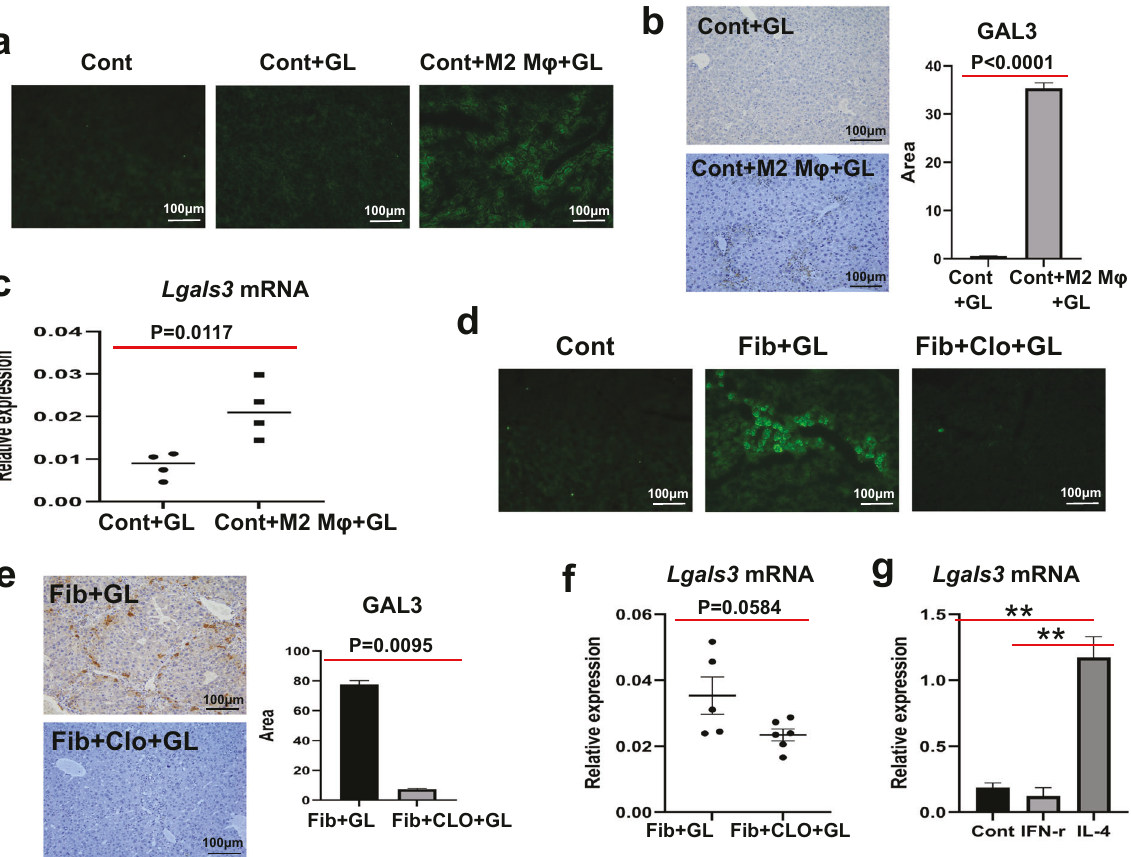
Fig. 4 M2-like macrophages act as a key regulator of GAL3 expression. a , b GAL3 expression in acutely injured mice with or without M2-like macrophage transfer. c The mRNA levels of Lgals3 in the livers of acutely injured mice with or without M2-like macrophage transfer. d , e GAL3 expression in fi brotic mice upon insult with or without M2-like macrophage depletion. f The mRNA levels of Lgals3 in the livers of fi brotic mice upon insult with or without M2-like macrophage depletion. g The mRNA levels of Lgals3 in M0, M1 or M2 macrophages ( a – c : n = 4; d – f : n = 4 – 6; g : n = 3). Group comparisons were performed using Student ’ s t test, the Mann – Whitney U test, or one-way ANOVA followed by Tukey ’ s multiple comparison test, ** P <